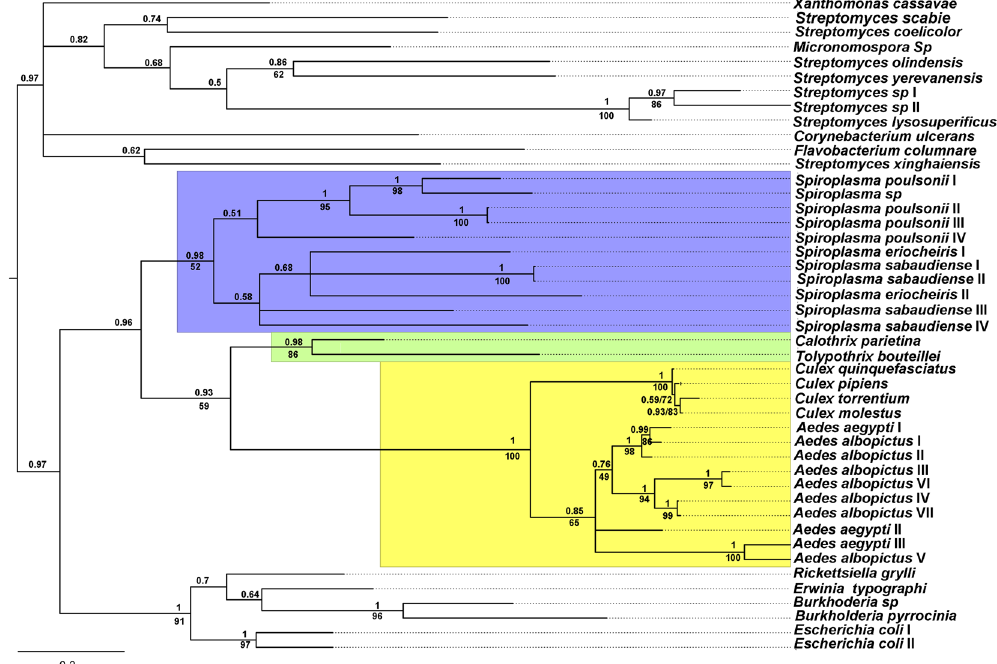
Figure 4. Phylogenetic relationships among Culicinae and bacterial RIPs. Bayesian tree topology based on matrix analysis of 45 proteins sequences with 275 informative sites is presented. Numbers above branches indicate PP support values. Bootstrap values (BS) > 50% are shown below branches for nodes where topology of ML analysis was coincident with Bayesian inference. Light blue, green and yellow backgrounds indicate Spiroplasma , Cyanobacteria and mosquito RIPs, respectively. Information related to the sequences used to infer these trees is available in Supplementary Table